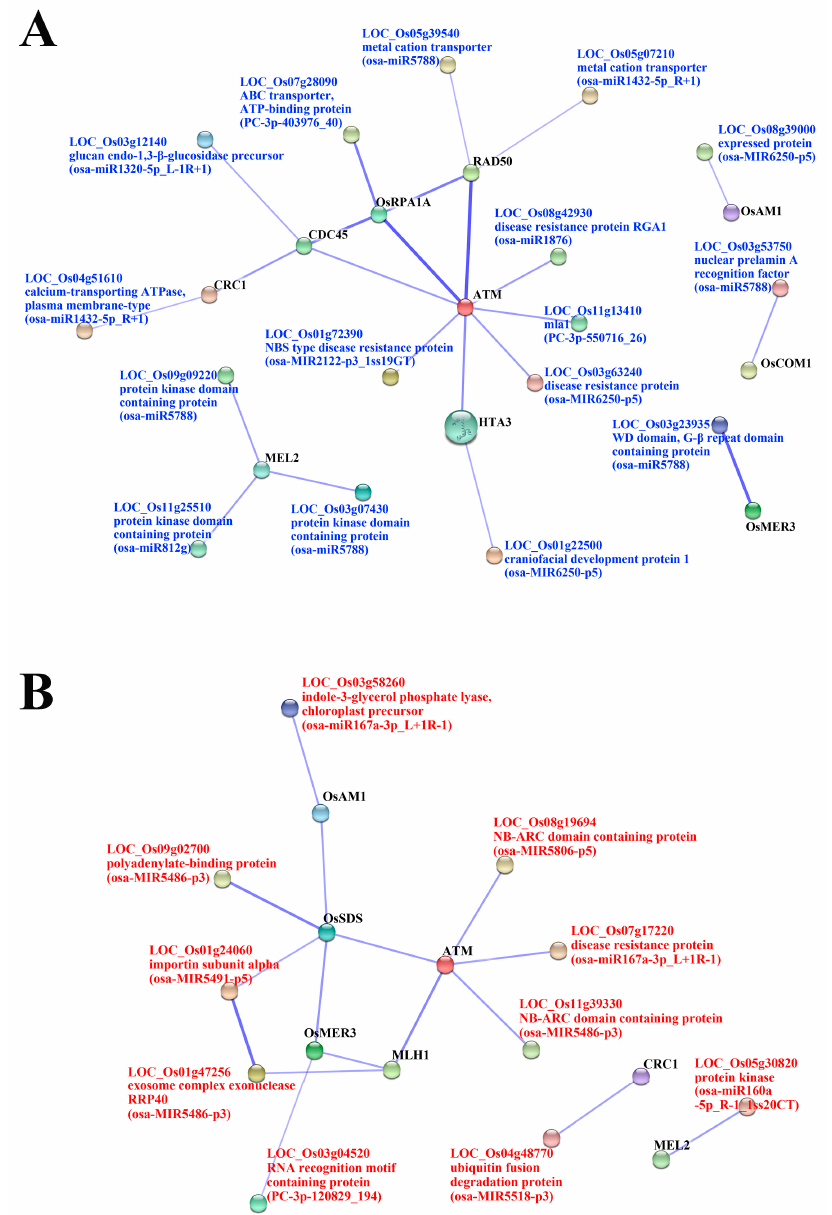
Figure 4. Protein interaction between the targets of DEM (differentially expressed miRNAs) and meiosis-related genes. The predicted targets of up-regulated ( A ) and down-regulated miRNAs ( B ) showed interaction with the meiosis-related genes (Black font). Blue font and red font represent the targets of up- and down-regulated DEM, respectively. Line thickness represents interaction between proteins/genes.